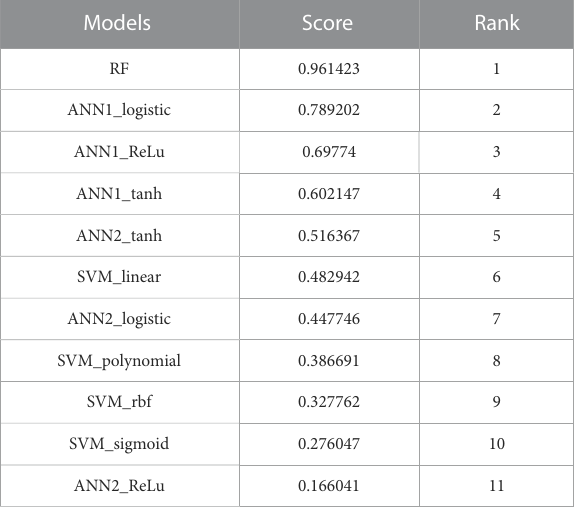
TABLE 7 TOPSIS analysis result for all eleven machine learning-developed models on the plant dataset.